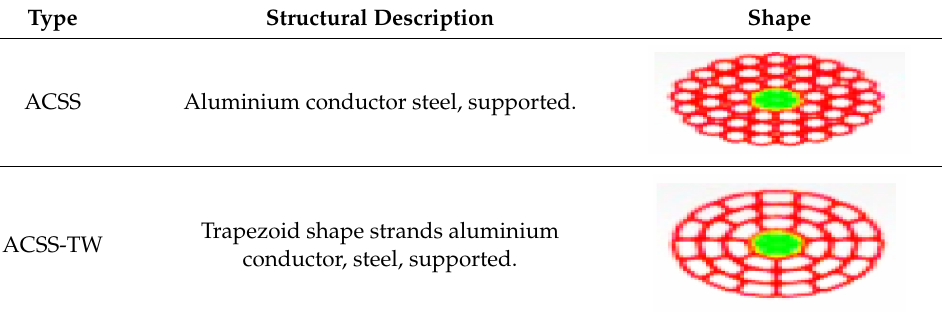
Table 1. Types of conductors [14].